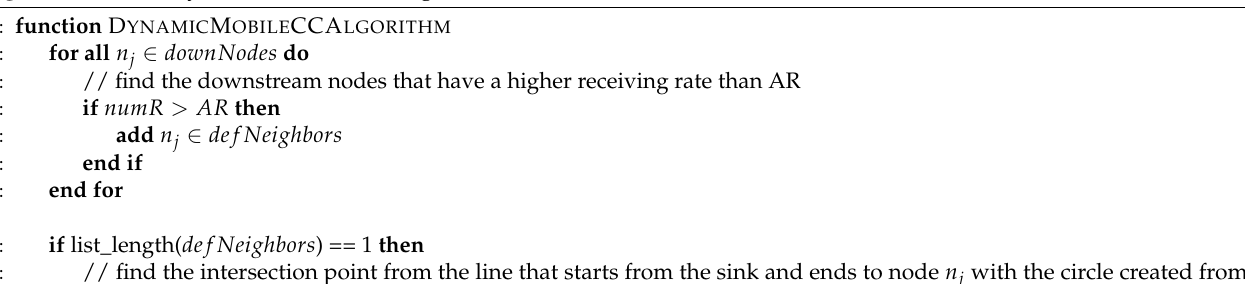
Algorithm 1 The Dynamic MobileCC